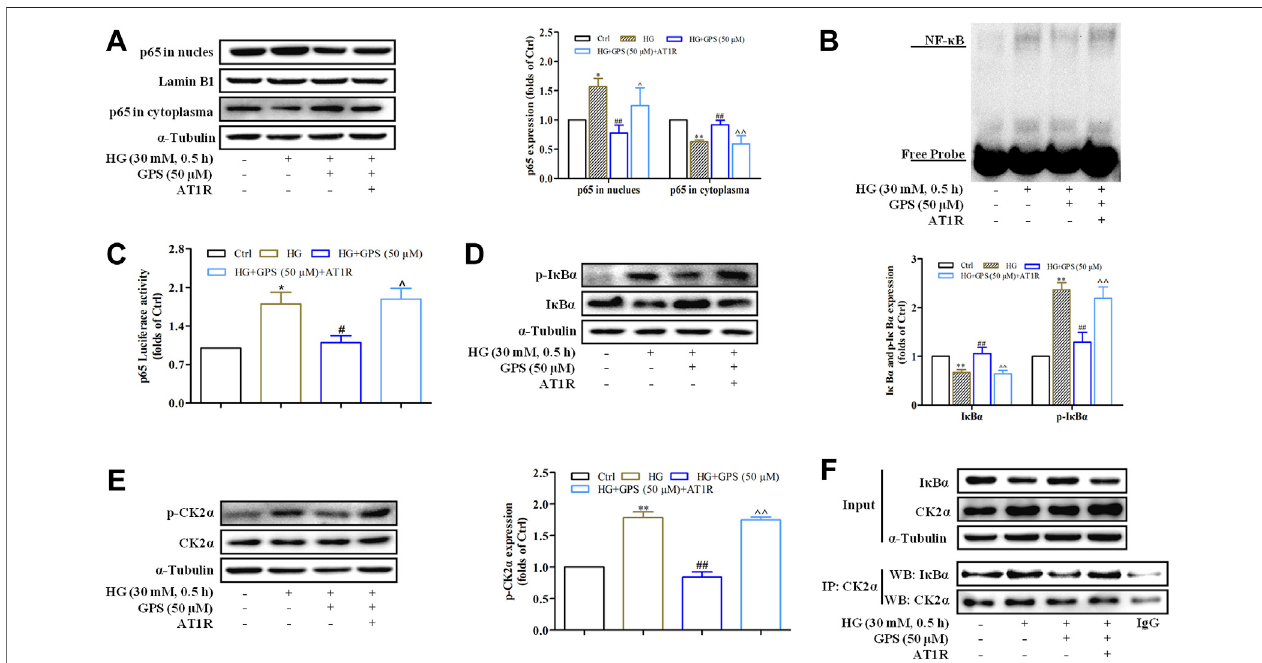
FIGURE 8 | AT1R over-expression reversed the effect of GPS on regulating the CK2/NF- κ B pathway. (A) Effects of GPS on p65 distribution in the nucleus and cytoplasm after AT1R over-expression were detected by Western blot. (B) Effects of GPS on the DNA NF- κ B p65 binding activity after the AT1R over-expression were detectedbyEMSA. (C) EffectofGPSontheNF- κ Bp65transcriptionalactivityaftertheAT1Rover-expressionwasdetectedbyluciferasereporterassay. (D,E) Effectsof GPSonproteinexpressionsofp-I κ B α ,I κ B α ,andp-CK2 α afterAT1Rover-expressionwasdetectedbyWesternblot. (F) BindingofCK2 α andI κ B α inNRK-52Ewas detected by immunoprecipitation. ** p < 0.01 and * p < 0.05 vs . Ctrl. ## p < 0.01 and # p < 0.05 vs . HG. ^^ p < 0.01 and ^ p < 0.05 vs . HG with GPS. Data were expressed as mean ±